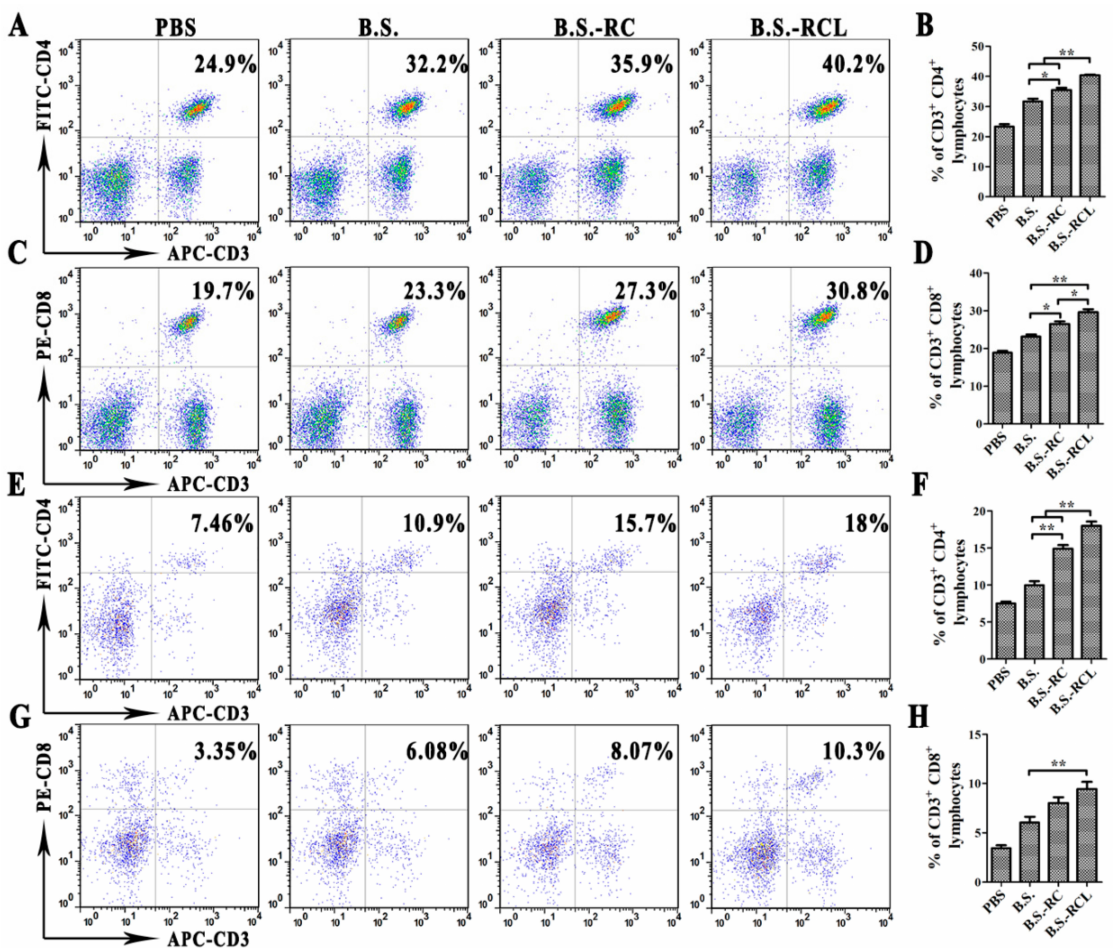
Figure 6. The changes of the local and systemic cellular immunity after oral immunisation. The MLN and spleen collected from mice 14 days after immunisation, and then, the percentages of CD3 + and/or CD4 + in MLN ( A , B ), CD3 + and/or CD8 + in MLN ( C , D ), CD3 + and/or CD4 + in the spleen ( E , F ) and CD3 + and/or CD8 + in spiralising ( G , H ) T cells were analysed by FACS (Signifcance diference was expressed as, * p < 0.05, ** p <